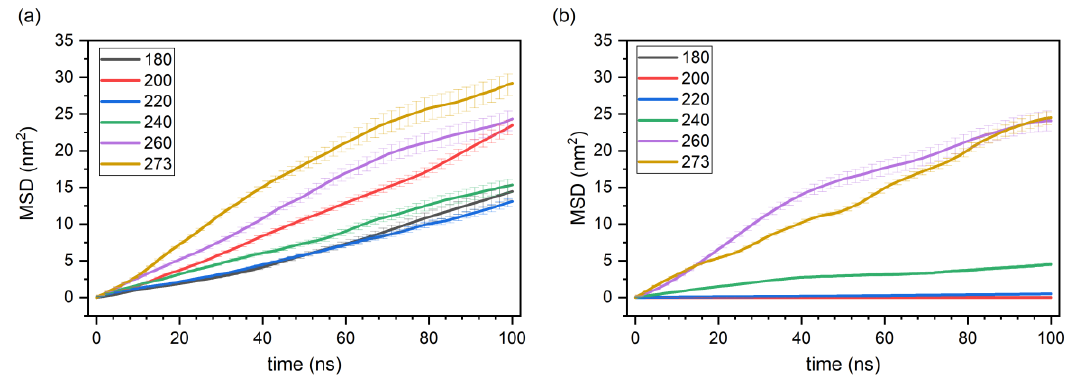
Figure 5. Mean-square displacement (MSD) curves of the hydrogen molecules in hydrate cages at various temperatures for both uptake ( a ) and release ( b ) simulation studies.